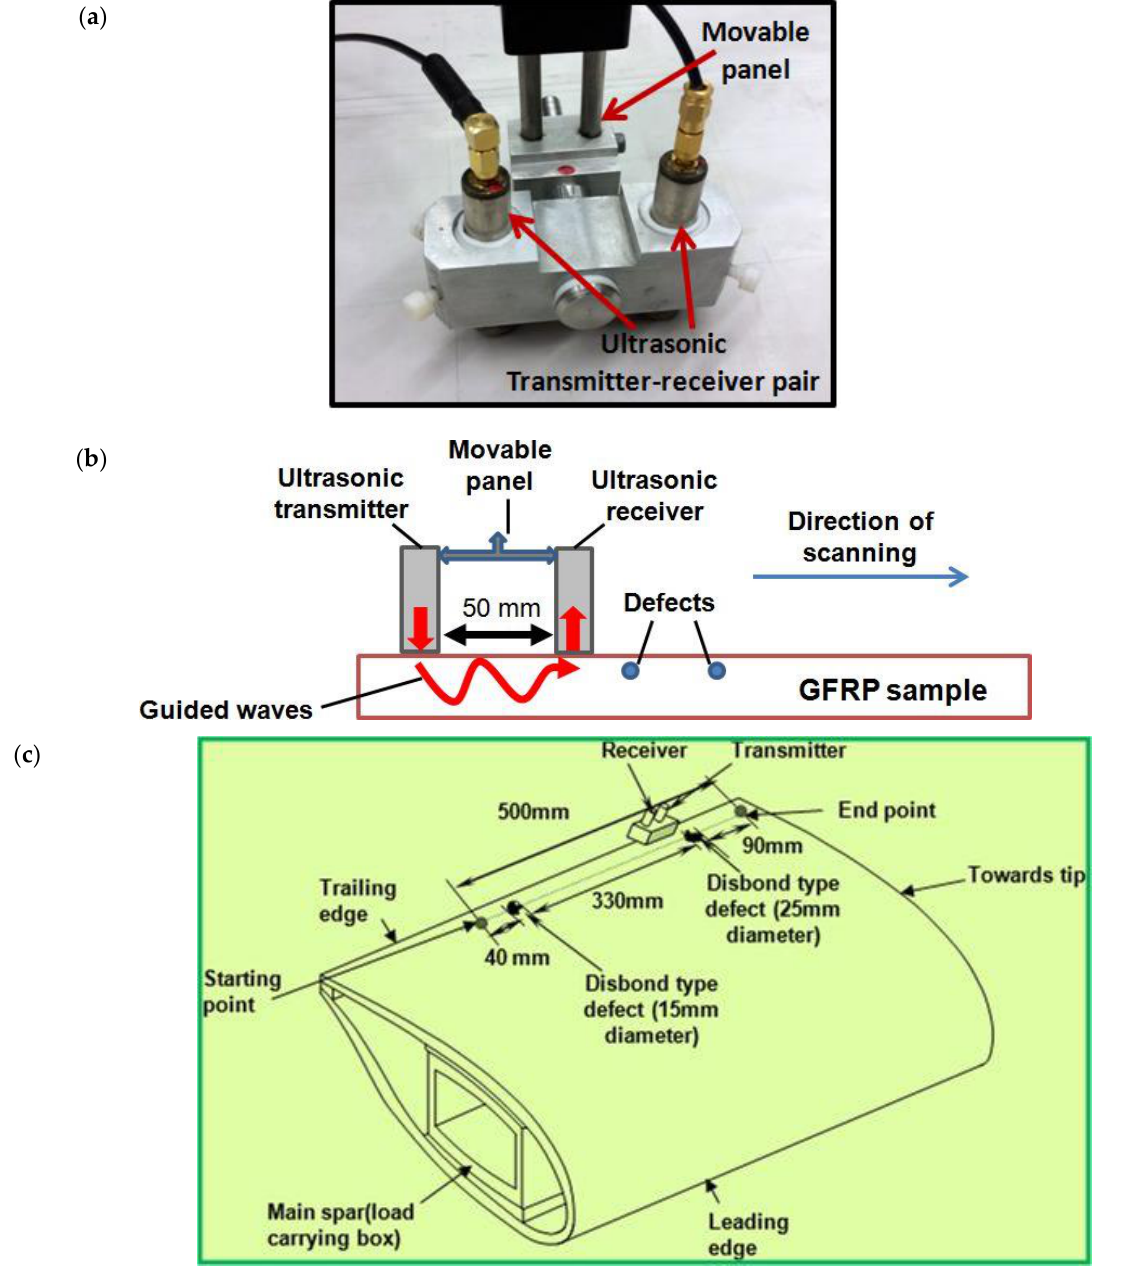
Figure 4. Experimental analysis of disbond type defects in GFRP sample (a segment of WTB): ( a ) photograph of a special arrangement of transmitter–receiver system during the experimental investigation; ( b ) schematic showing the working principle of transmitter–receiver system for GW testing; ( c ) schematic showing the complete arrangement of the scanning process for estimation of 15 mm and 25 mm diameter defects present on the trailing edge of the sample.